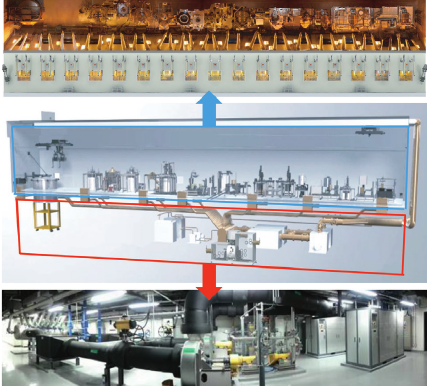
Figure 2: Argon circulation system for PRIDE facility (Top: Top view of argon cell, Middle: Cut view of argon cell, Bottom: Photo of argon circulation system operated under the argon